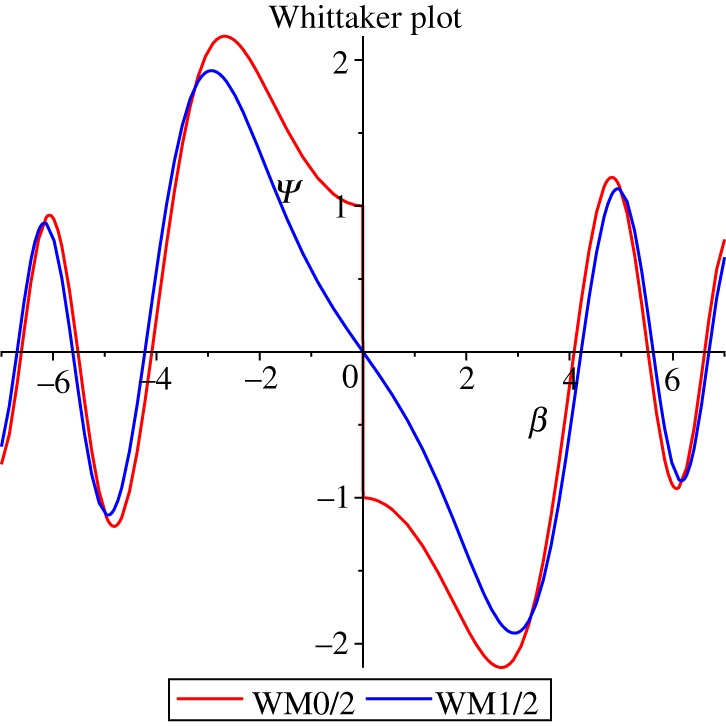
1=2σ=ℏ=CM, 0=CW, red (ı−1)WM(ε=0), blue ıWM(ε=1).